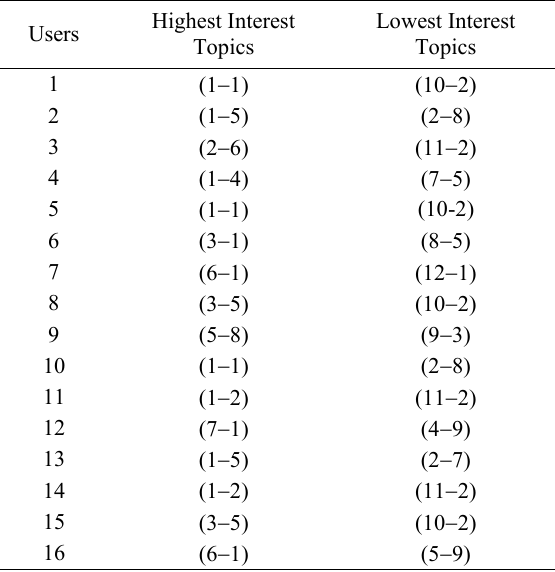
Table 2. Highest and lowest interest topics of multiple